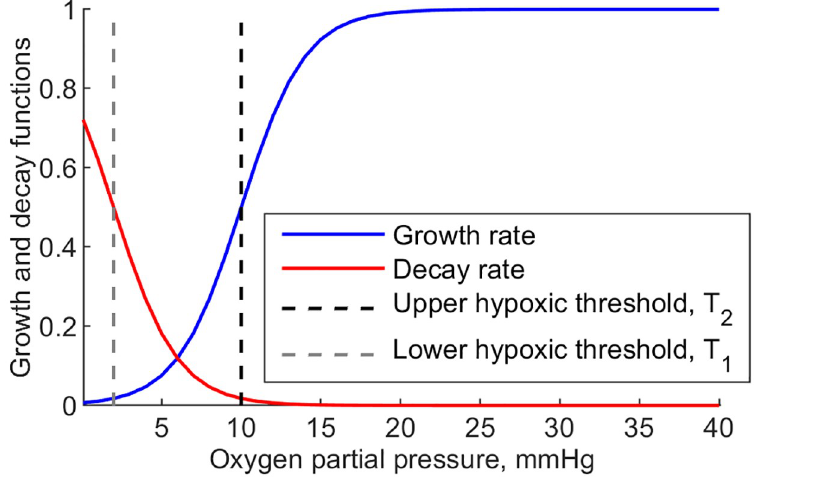
Fig 6. Growth and decay as functions of oxygen partial